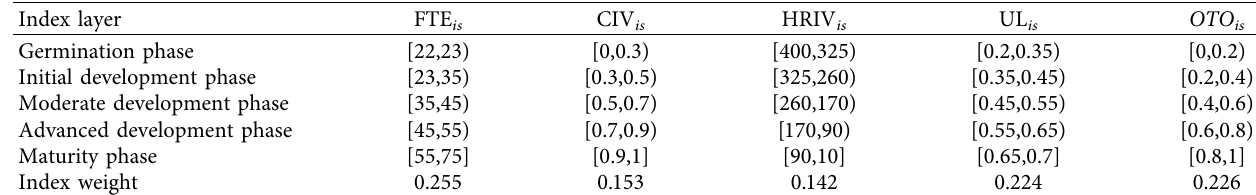
Table 1: Value range for each index.